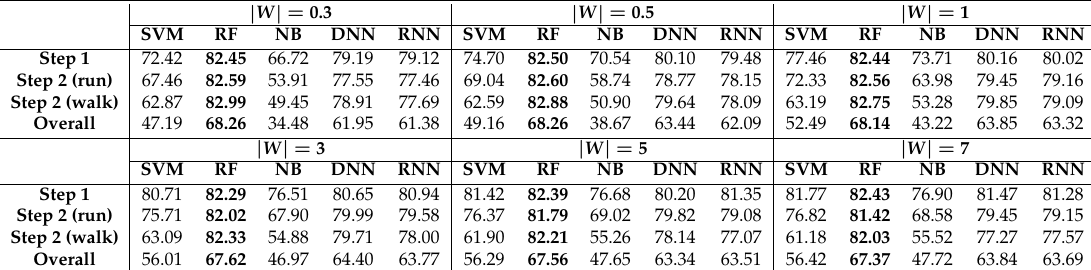
Table 6. Accuracies of action-possession recognition for different lengths of